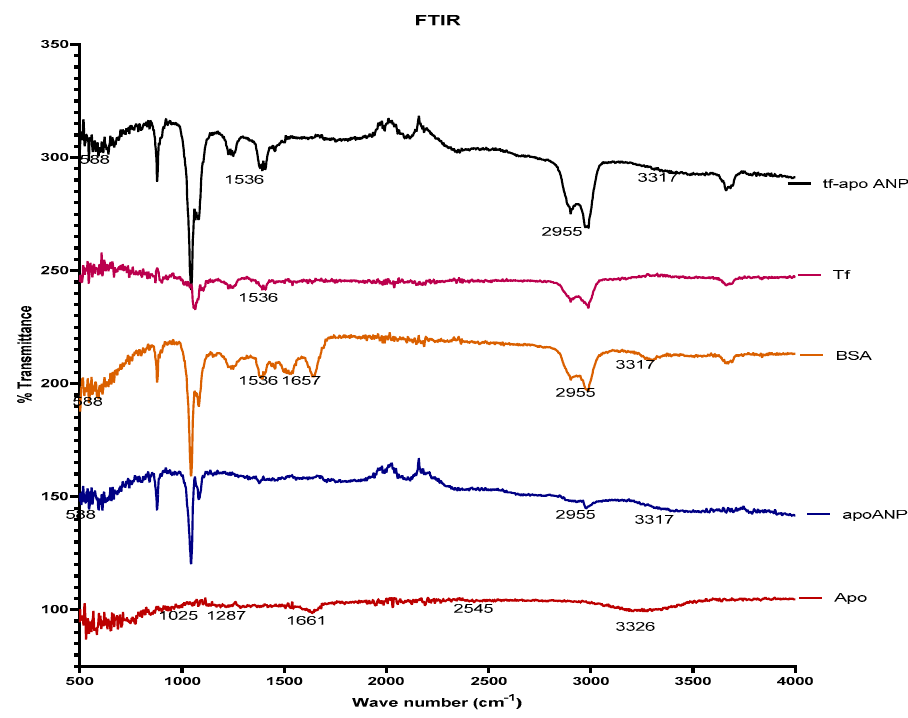
Figure 3. FTIR spectra of BSA, transferrin apocynin, apoANPs, and tf-apoANPs.